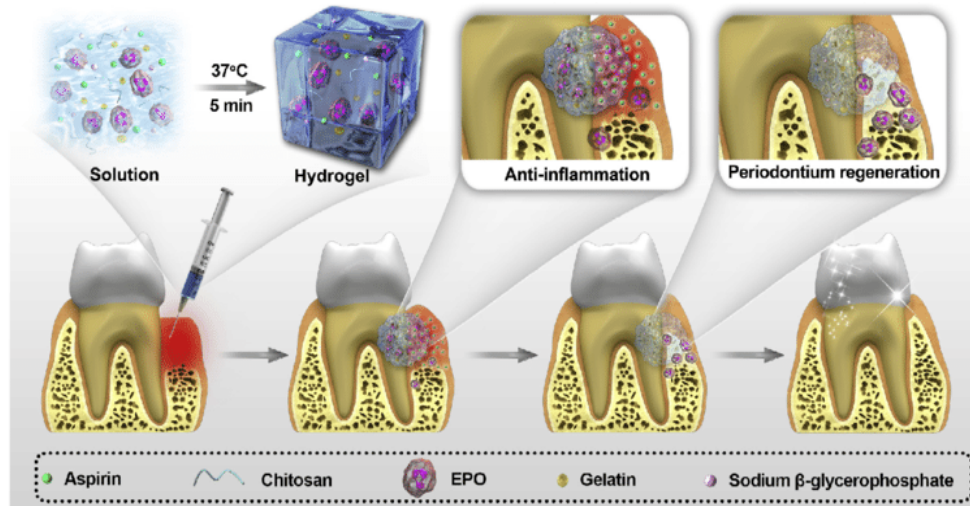
Figure 4. Schematic representation of thermoresponsive hydrogel prepared from chitosan / sodium - β -glycerophosphate / gelatine for promoting periodontal regeneration. Reprinted from [81] with permission from Elsevier.